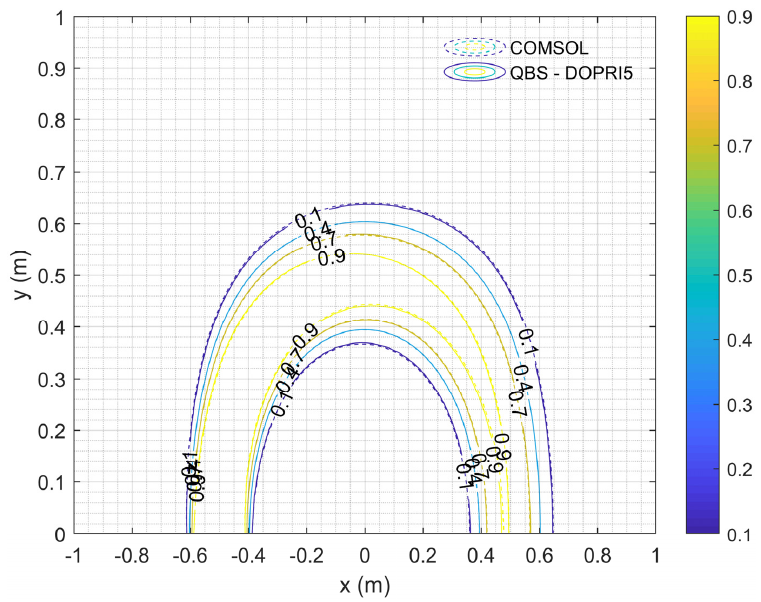
Figure 9. Concentration field obtained by QBS-DOPRI5 (∆(cid:1876) = ∆(cid:1877) = 0.01 m) and COMSOL Multiphysics at time 1.7 days for Scenario B. Multiphysics at time 1.7 days for Scenario B.